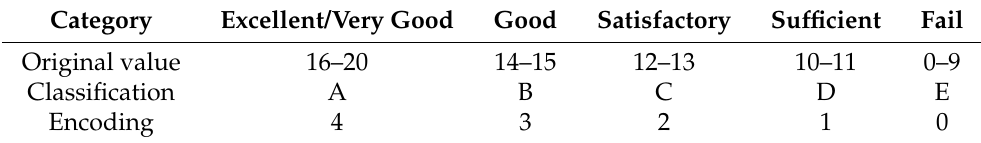
Table 1. The five-level classification